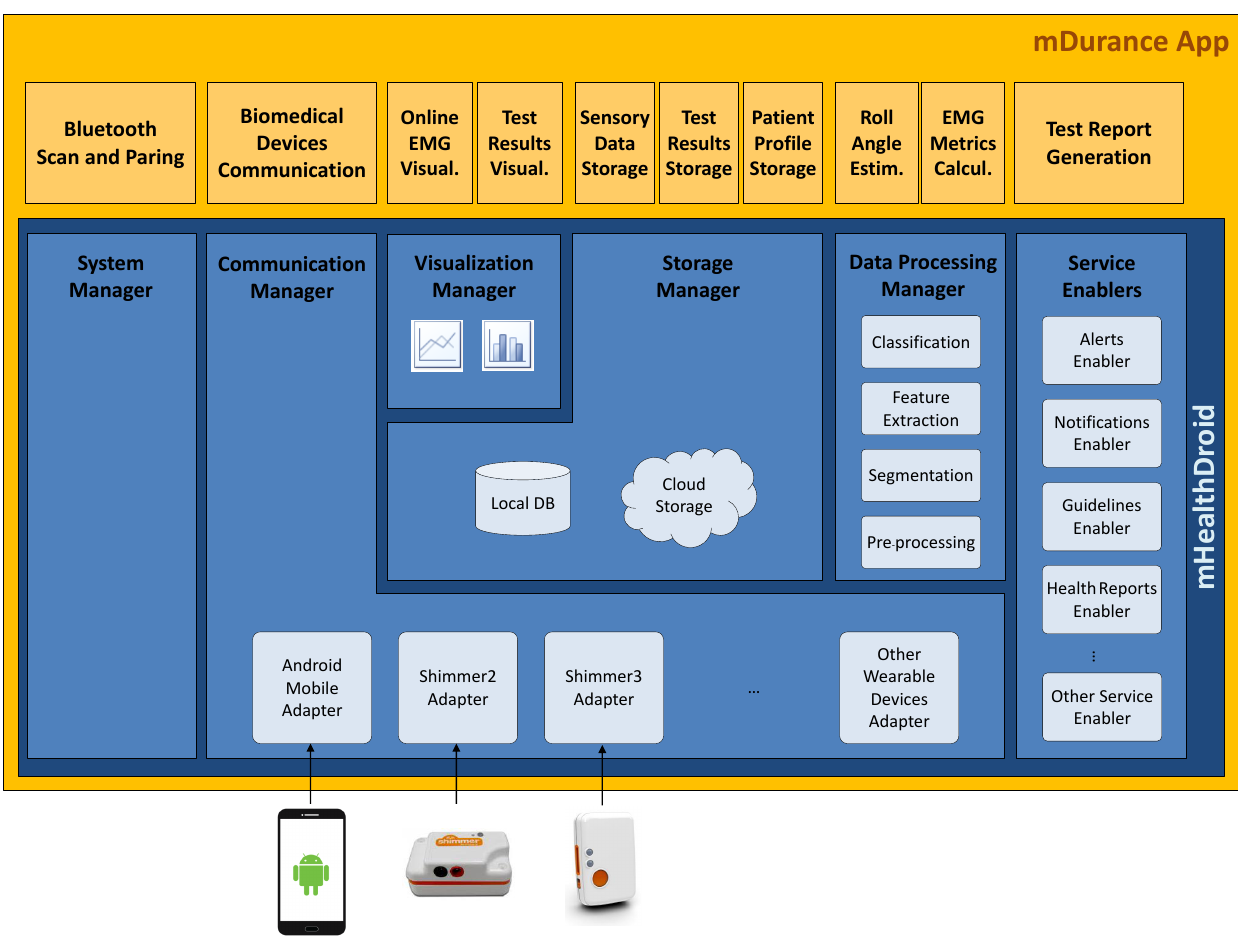
Figure 5. mDurance architecture building on